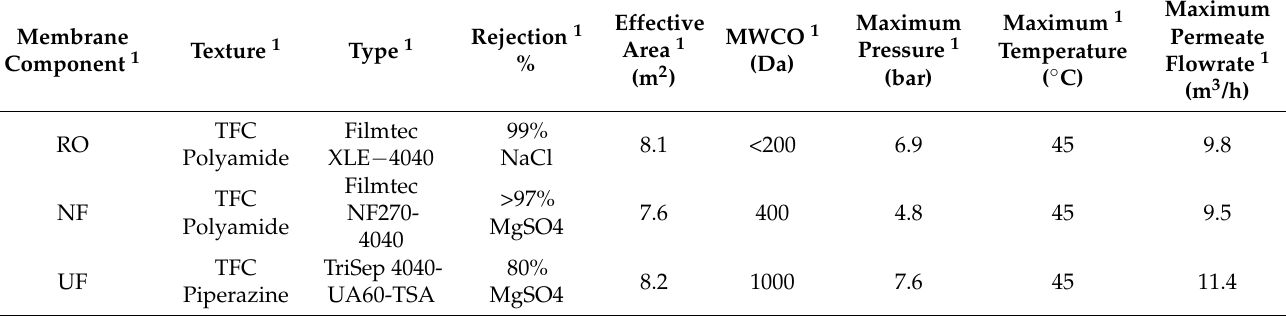
Table 3. Properties of three membrane